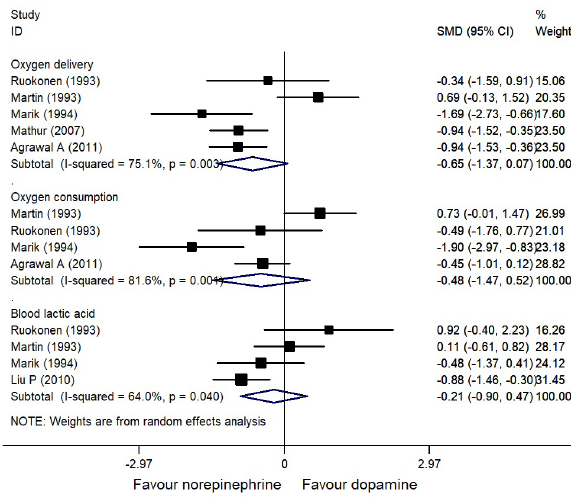
Figure 3: The forest plot of Pooled oxygen metabolism index for norepinephrine versus dopamine in treatment of septic